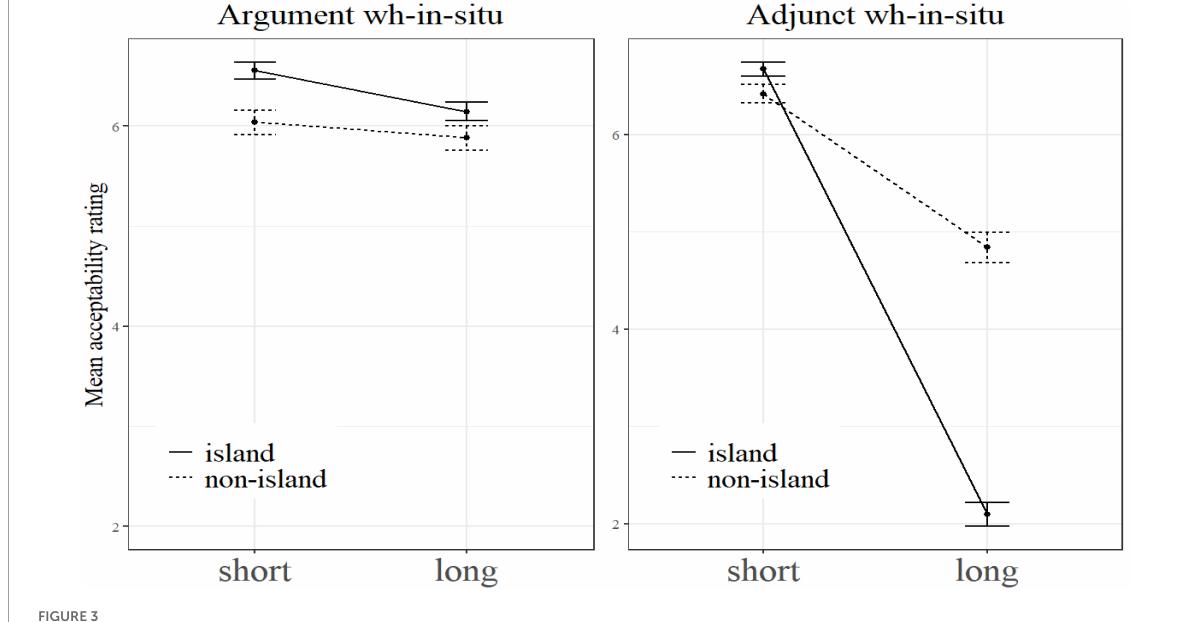
FIGURE3 The interaction plots for argument wh -in-situ and adjunct wh -in-situ.